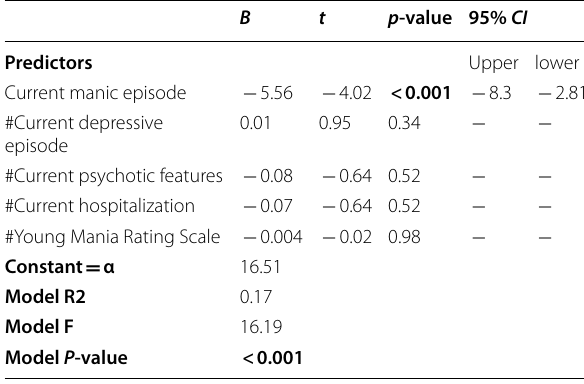
Table 5 Stepwise multiple linear regression analysis for prediction of serum IL-6 levels in